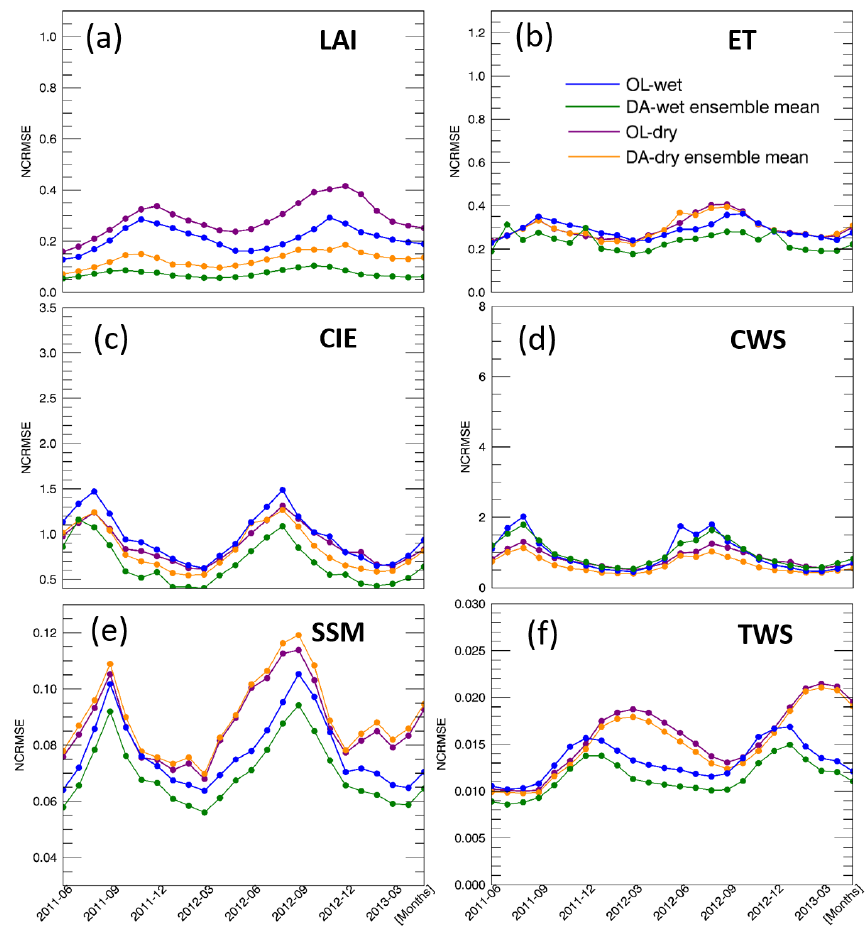
Figure 7. Same as in Fig. 6 but for the Southern